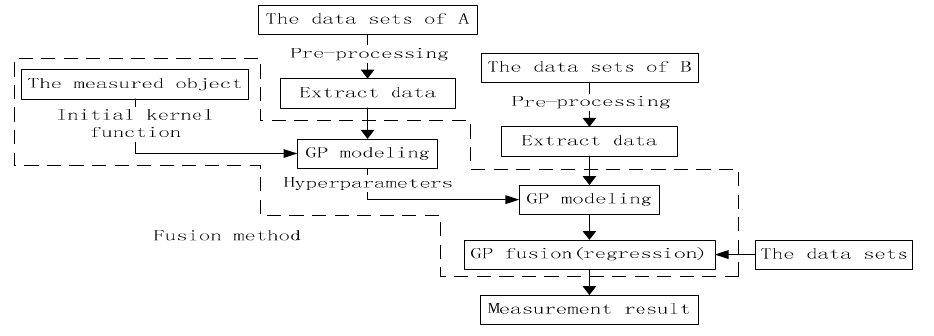
Figure 4. Framework of data fusion.